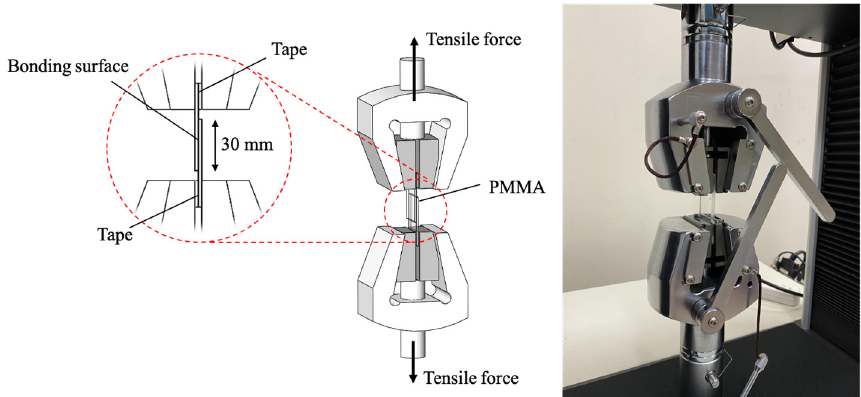
Figure 2. Experiment setup of tensile strength measurement.